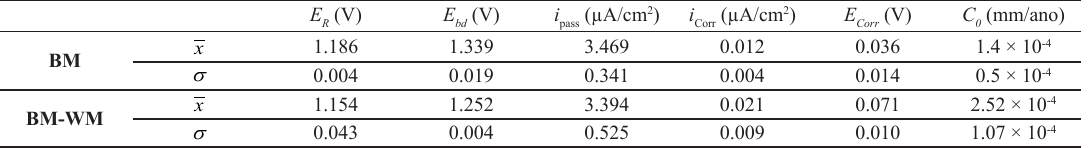
Table 4. Mean values and standard deviations of the parameters of interest in the triplicate crevice tests in BM and BM-WM in NaCl 3.5% solution (20 ± 2